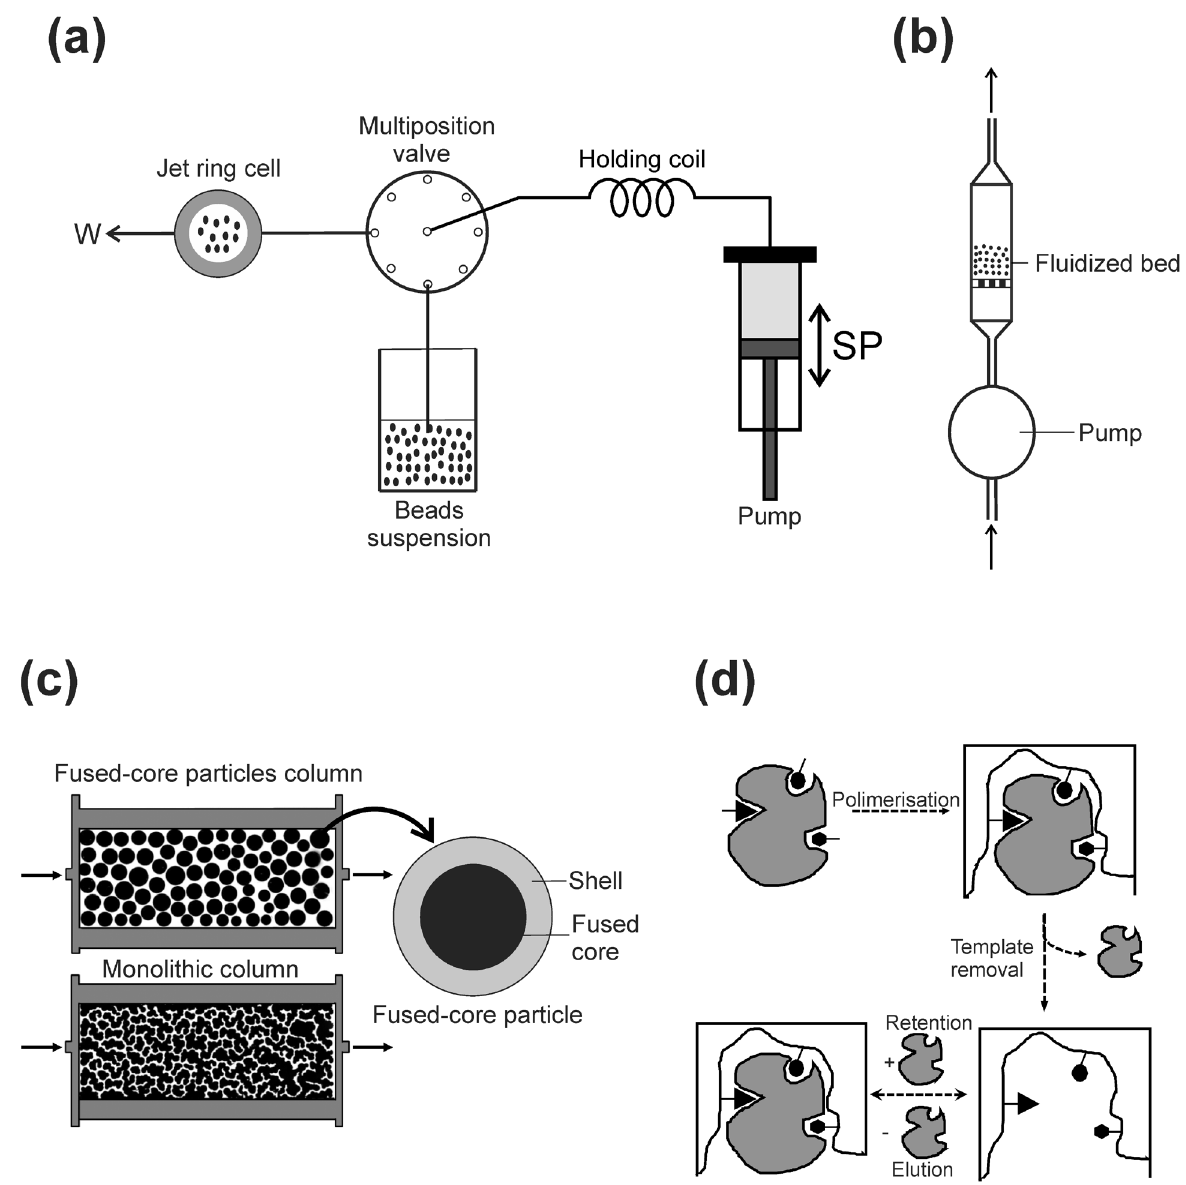
Figure 2 - Some approaches for flow-based SPE: ( a ) bead injection; ( b ) fluidized beads; ( c ) low-pressure chromatography, and ( d ) molecularly imprinted